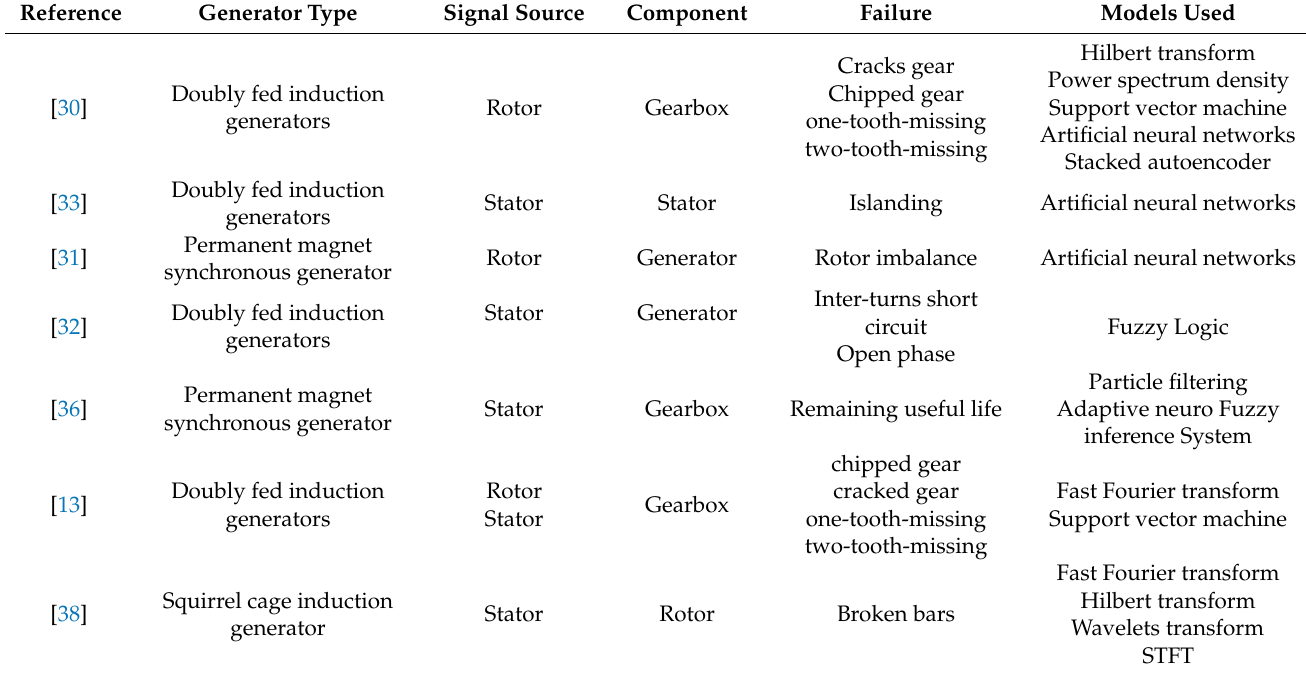
Table 2. Proposals on fault detection in WTs using current signal and AI